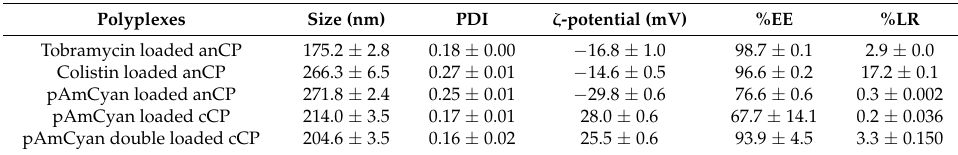
Table 2. Summary of characteristics of drug-loaded anCP, %EE = encapsulation efficiency